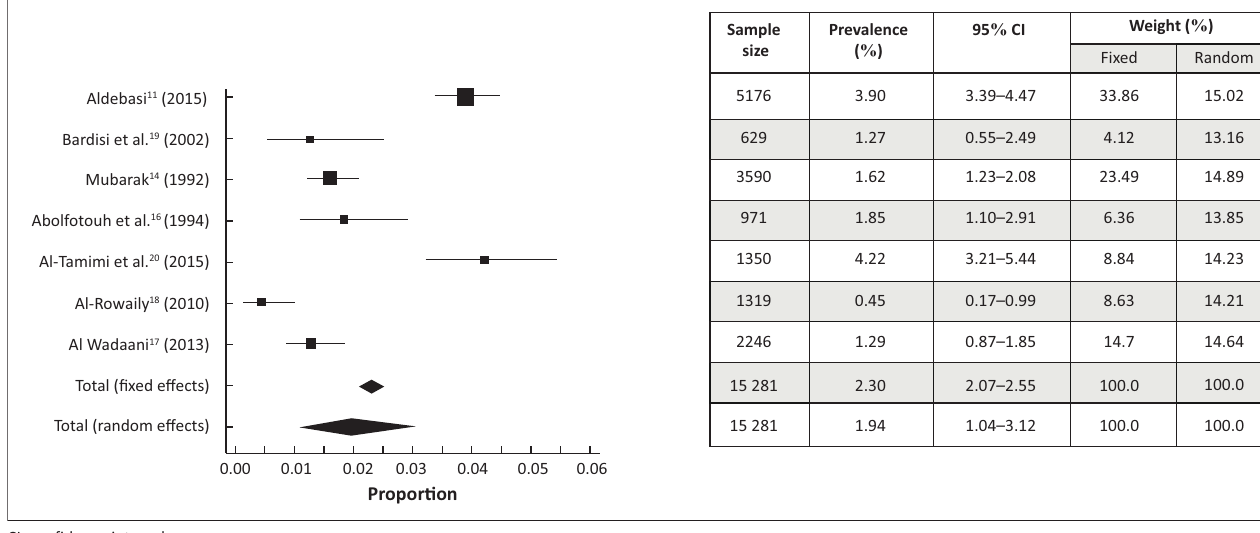
FIGURE 3: Forest plot showing the prevalence of amblyopia from various studies conducted in Saudi Arabia. Extended lines indicate 95 % confidence intervals as found in the seven studies. The corresponding weight and proportionate prevalence of each study are summarised in the table on the right side of the